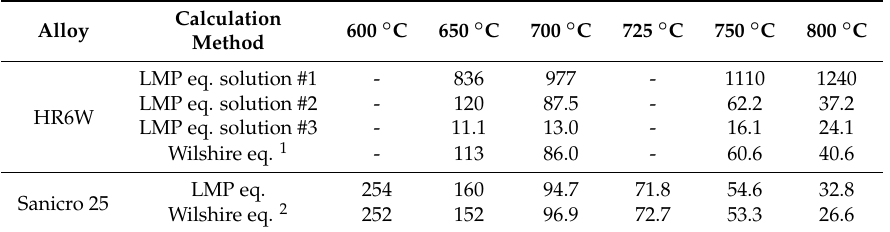
Table 10. Calculated creep strength for rupture at 100,000 h (MPa).